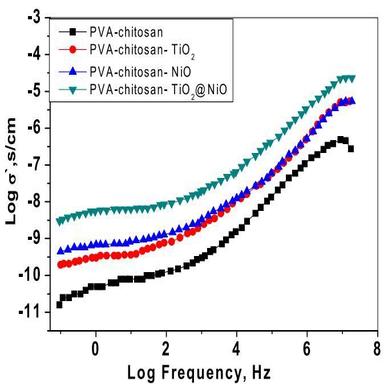
Variation in the AC conductivity of the PVA-chitosan–TiO2, PVAchitosan–NiO, and PVA-chitosan– TiO2@ NiO films.